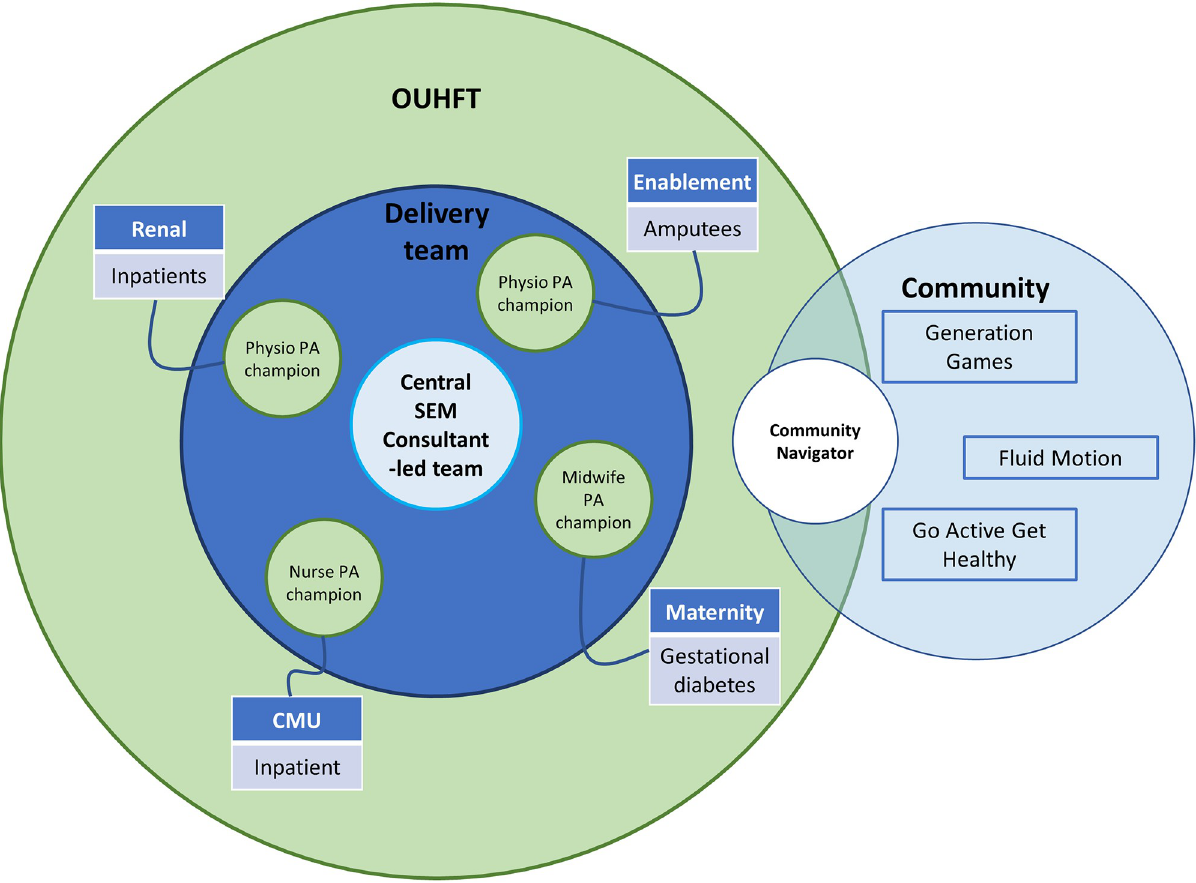
Fig 1. Schematic representation of the Active Hospital pilot SEM Consultant-led model. Qualitative evaluation was conducted in three of the four clinical pathways (Enablement, Renal and CMU). (OUHFT, Oxford University Hospital Foundation Trust; PA, physical activity; SEM, Sport and Exercise Medicine;; CMU, complex medical